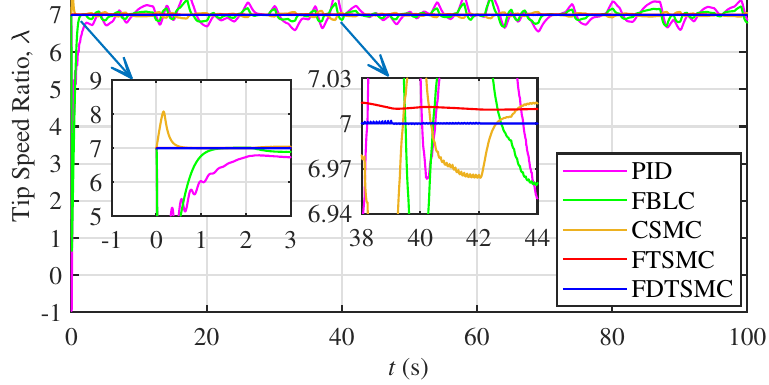
Figure 8. Tip speed ratio performance.